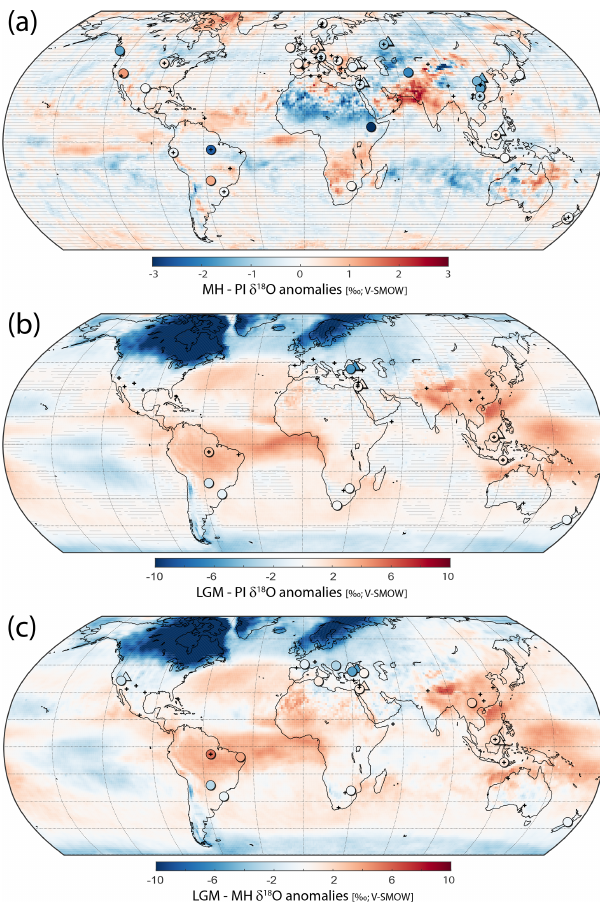
Figure 5. ECHAM5-wiso weighted δ 18 O p anomalies (‰; V- SMOW; background map) and SISAL isotope anomalies (‰; V- SMOW; filled circles) for three time slices: (a) MH-PI (SISAL records, n = 36), (b) LGM-PI (SISAL records, n = 13) and (c) LGM–MH (SISAL records, n = 22). For easy visualization, when there are two speleothem records from the same cave site, one has been shifted 2 ◦ towards the north and the east (shown here as triangles). Note the different colour bar axis in the colour bar of (a) compared to (b) and (c) . Two-tailed student t test has been ap- plied to calculate the significance of the ECHAM5-wiso anomalies in (a) and (b) at a 95% confidence. No significance has been cal- culated for (c) , which compares two different simulations with their corresponding control periods. SISAL anomalies calculated with re- spect to 1850–1990CE. Small black crosses indicate SISAL entities that do not have a modern equivalent. SISAL data have been con- verted to their drip water equivalent prior to calculating the anoma- lies as described in Sect.